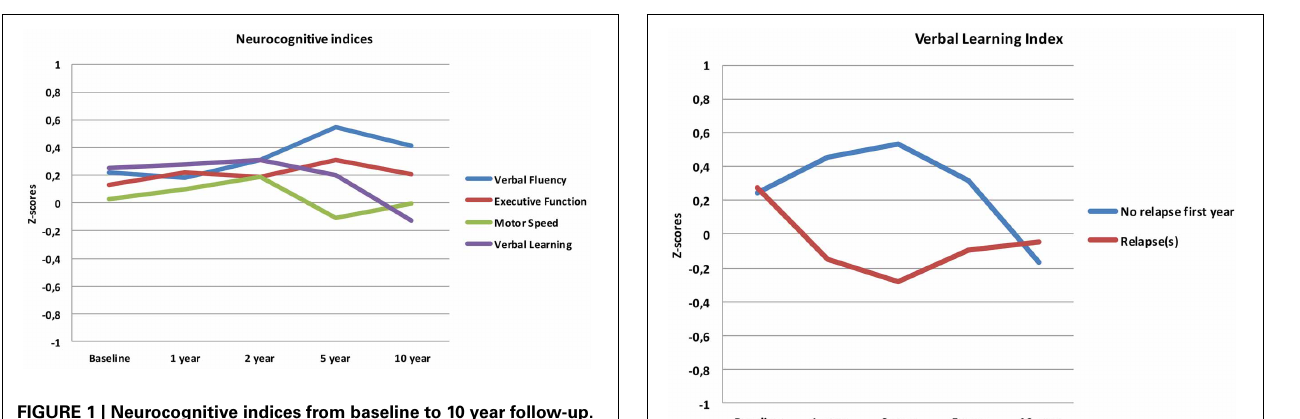
FIGURE 1 | Neurocognitive indices from baseline to 10 year follow-up.